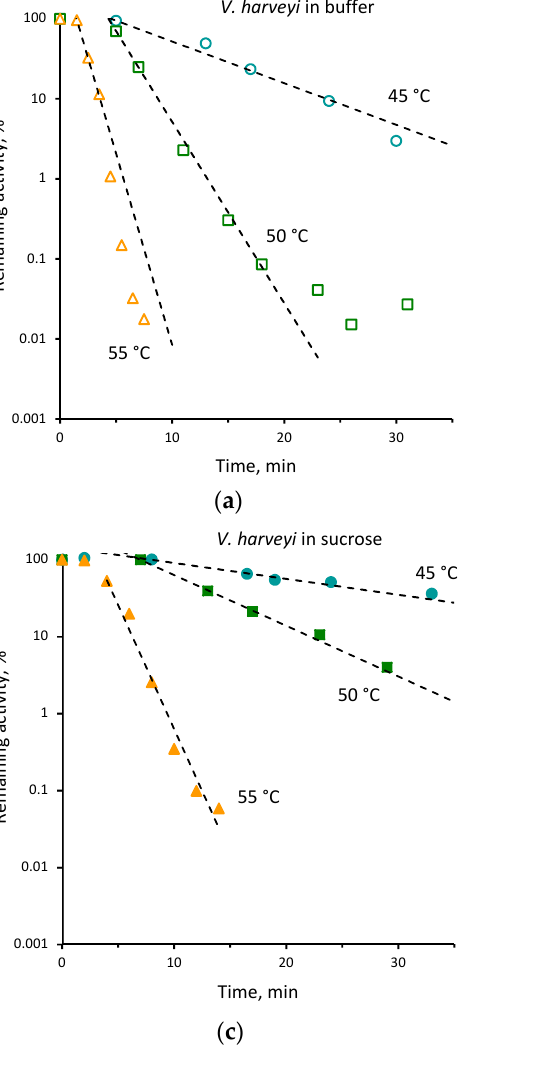
Figure 3. The dependence of the remaining activity of V. harveyi ( a , c ) and P. leiognathi ( b , d ) luciferases in the buffer ( a , b , empty markers) and sucrose solution ( c , d , filled markers) on the incubation time at selected temperatures (45 °C—circles, 50 °C—squares, 55°C—triangles) in semi-logarithmic scales. Lines refer to approximations with exponential function. Concentrations in the reaction mixture were: luciferase—0.5 µM, flavin—15 µM, decanal—50 µM. The activity was measured at 20 °C after the immediate cooling of the incubated enzyme.